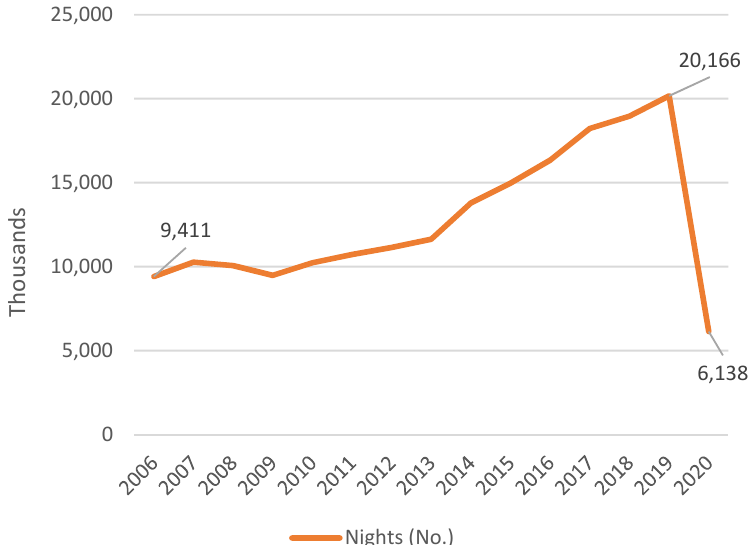
Figure 6. Nights (No.) in collective tourist accommodations in Lisbon’s Metropolitan Area. Source: INE.